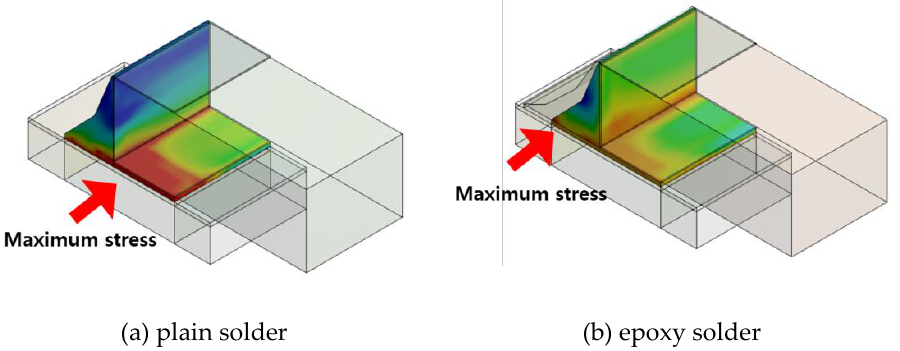
Figure 5. Location of maximum stress in solder joints. ( a ) plain solder; ( b ) epoxy solder.